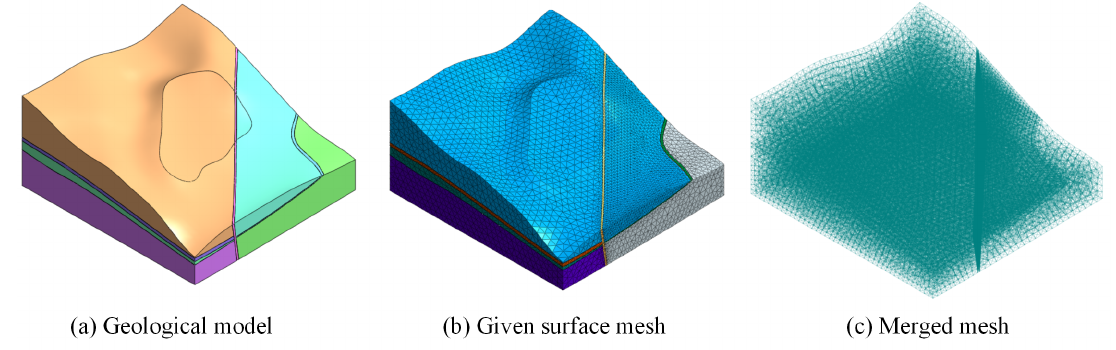
Figure 6. Procedure of the bubble mesh method for a three-dimensional